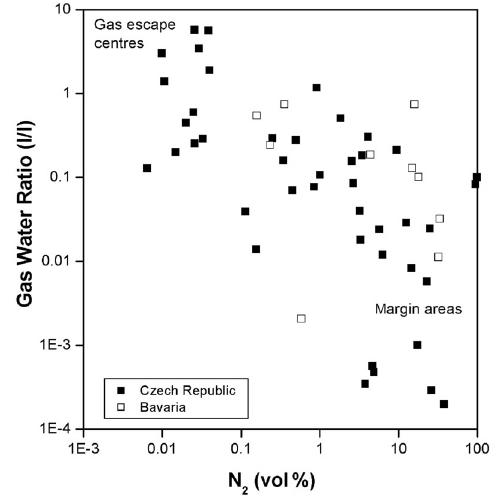
Fig. 4. Rise of N 2 (air-free) in gases with decreasing free gas-water ratio due to increased gas fractiona- tion, i.e. selective CO 2 solution in water. The un- avoidable scattering in the data is due to varying air proportions in the gases by different partial pressures influencing the bubble point pressure of the gas-water systems (data from Weinlich et al ., 1998,